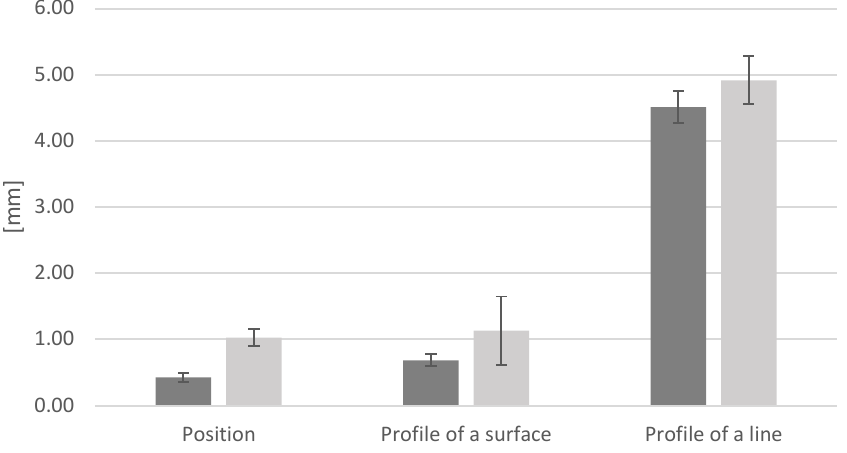
Figure 7. Comparison of the determined position and profile tolerance values of different Lego bricks scanned by Artec Space Spider and the iPad Pro (2020) using TrueDepth.